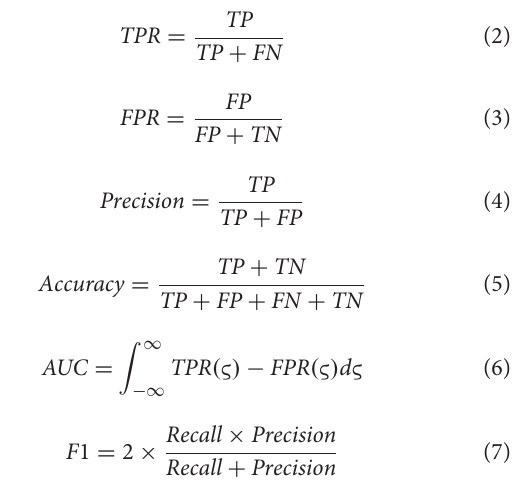
FIGURE 4 | Final CNN architecture for separating PD from